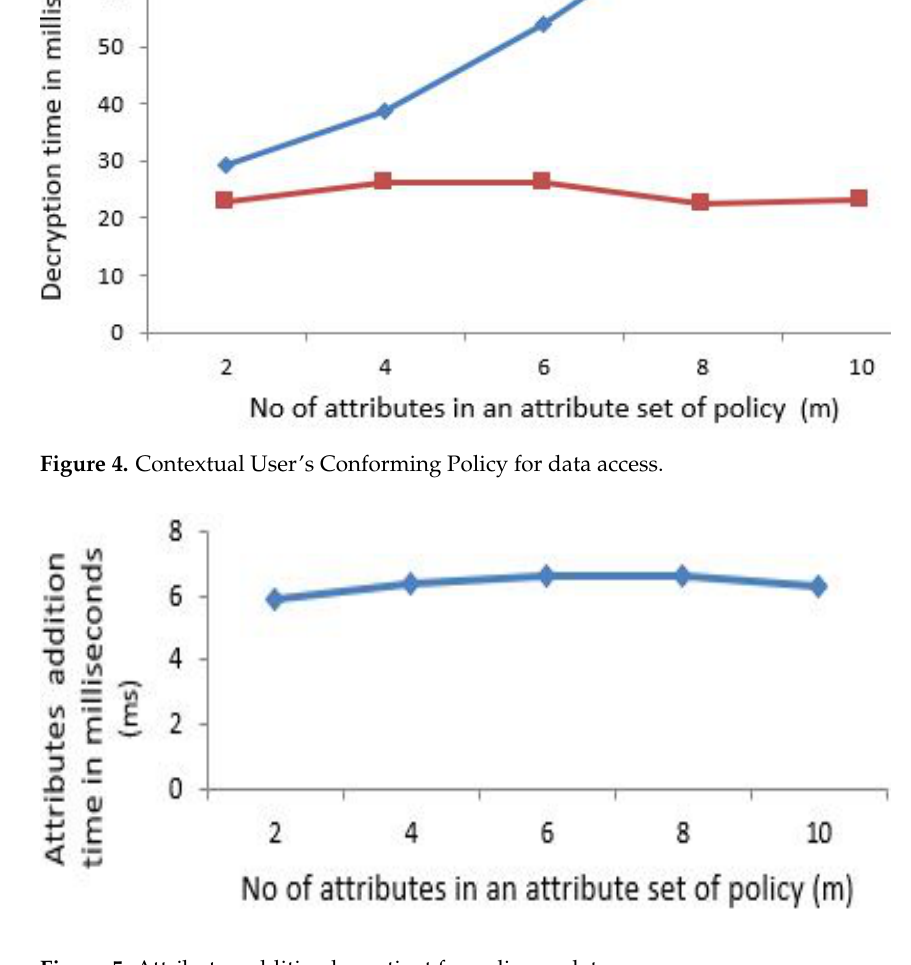
Figure 5. Attributes addition by patient for policy update.